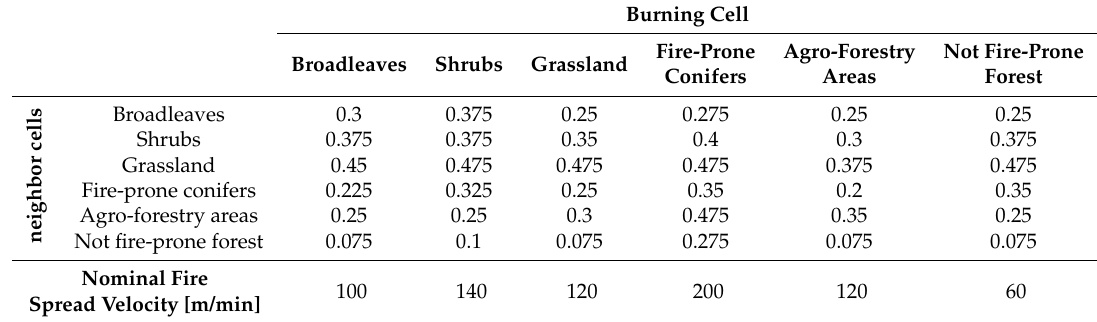
Table 1. In the first six rows, the values of the nominal fire spread probability p n between all the species are given. In the last row, nominal fire spread velocity v n is reported. Burning Cell Broadleaves Shrubs Grassland